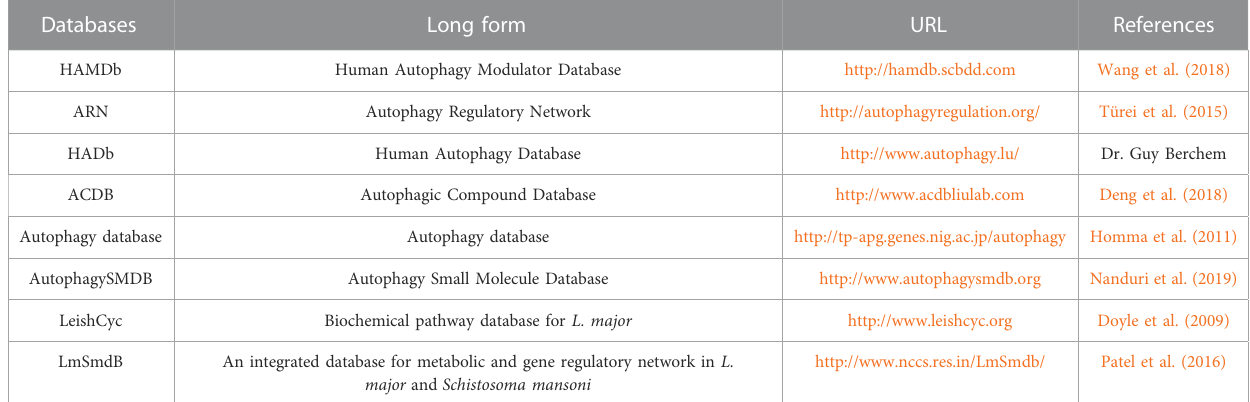
TABLE 3 Databases of autophagy and Leishmania